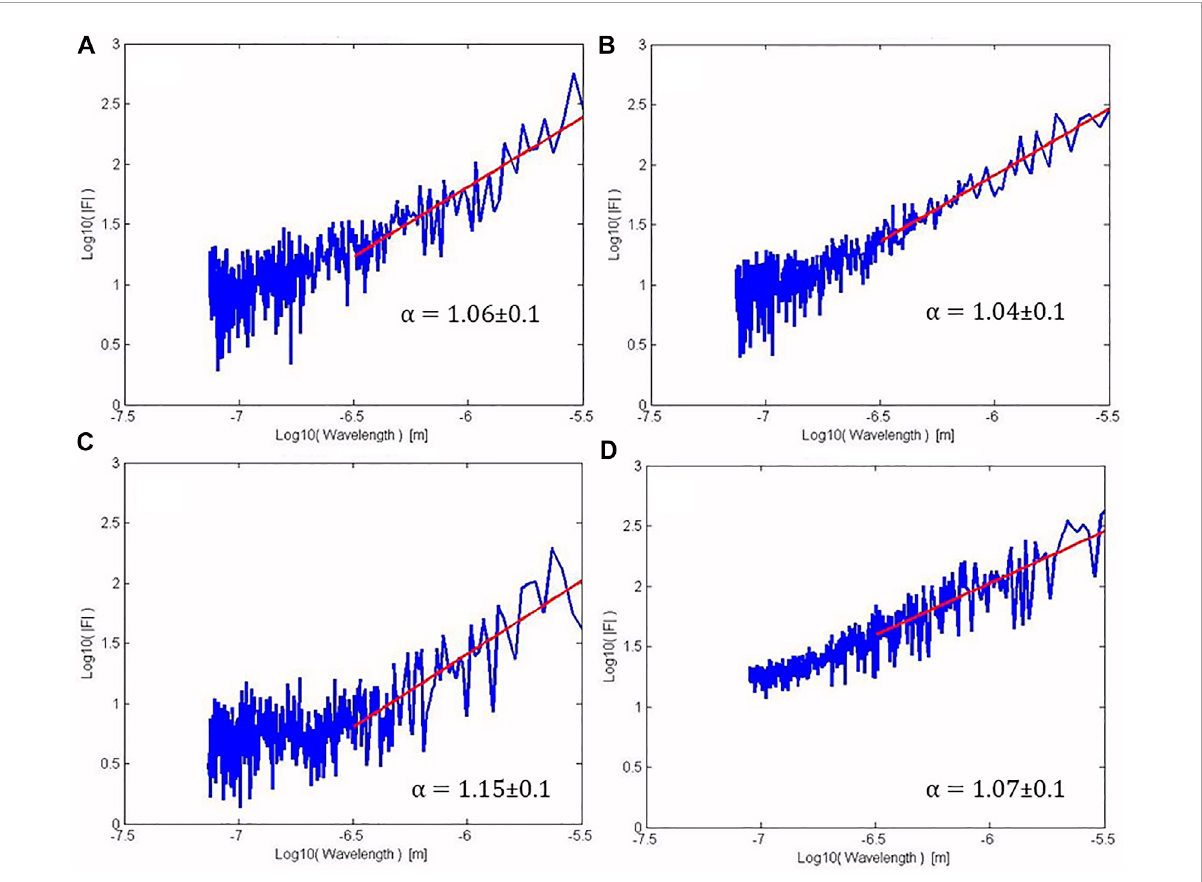
FIGURE 9 FFT spectra, Log 10 | F | vs. Log 10 λ [m], of different fabrics measured along longitudinal lines for (A) untreated, (B) sprayed, (C) plasma-treated and sprayed, and (D) plasma-treated-only samples. The power law fits to the longer scale regions are also shown, and the corresponding values of α are reported in